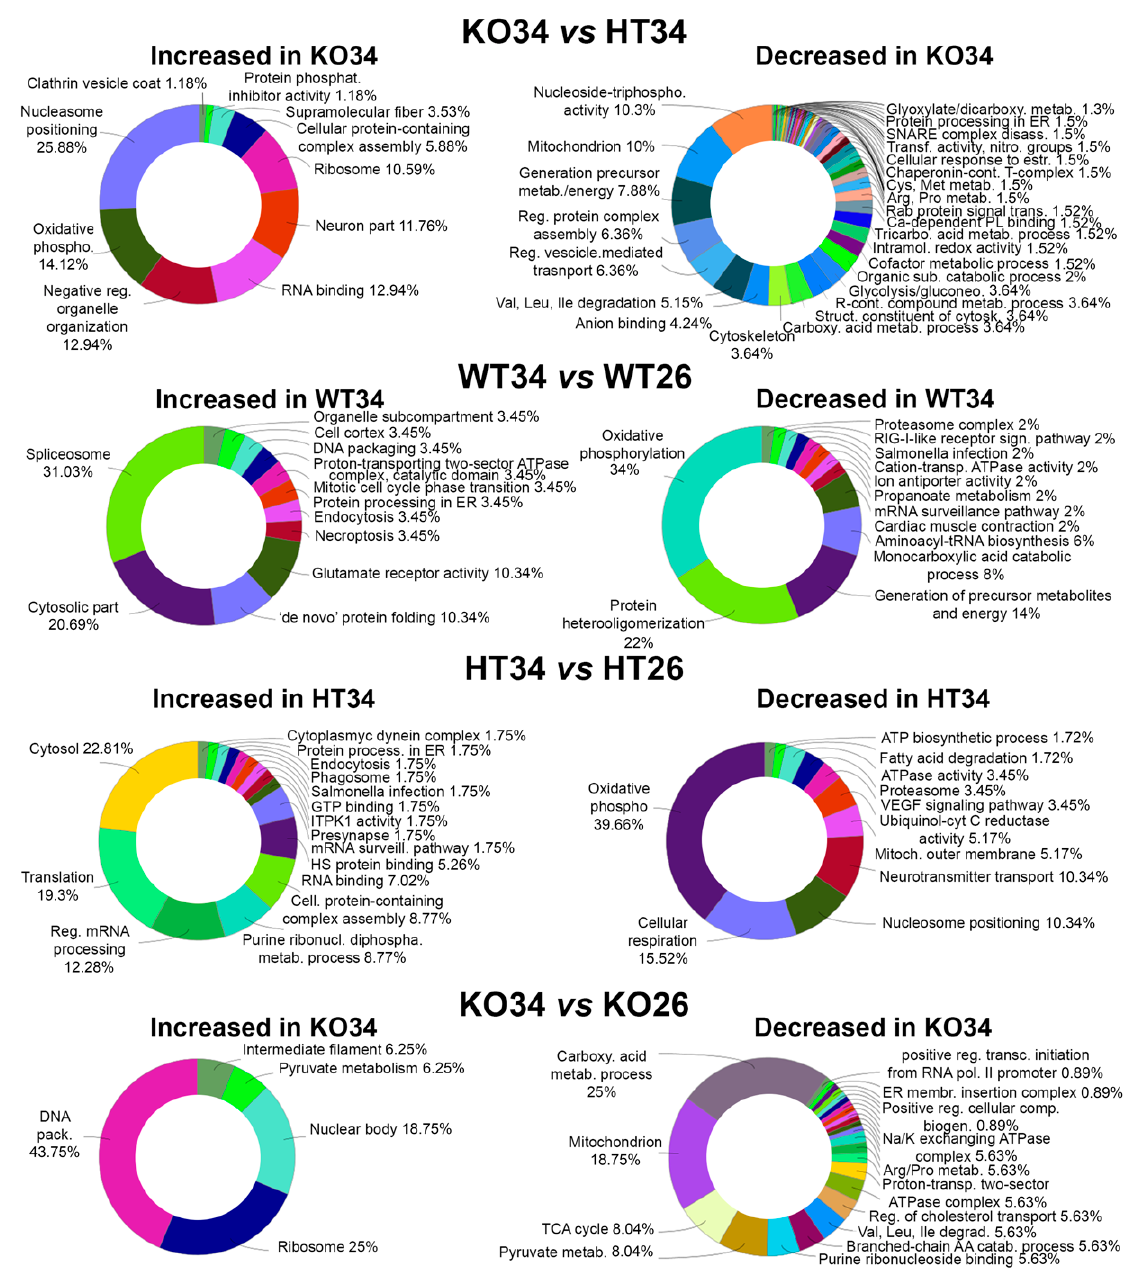
Figure 4. Bioinformatic analysis by ClueGo of the proteins differentially or exclusively expressed in KO34 vs. HT34, WT34 vs. WT26, HT34 vs. HT26, KO34 vs. KO26. Bioinformatic analyses were carried out by ClueGo software (Cytoskape release 3.8.2) to cluster enriched annotation groups of biological processes, pathways, and networks within the set of differentially expressed or exclusively expressed proteins in the comparisons. Functional grouping was based on p ≤ 0.05. Functional grouping was based on p ≤ 0.05 and at least three counts.